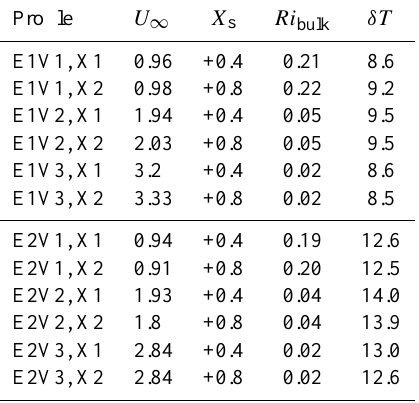
Table 1. Experimental setup for six atmospheric profiles with am- bient wind velocity V ∞ (ms − 1 ), fetch distance over the snow patch X s (m), the bulk Richardson number Ri bulk , and the temperature difference between the surface and the ambient air temperature δT ( ◦ C). The labels of profiles refer to their position ( X = X s ), ambient wind velocity ( U = U ∞ ), and the shape of the snow surface (flat: E1; concave: